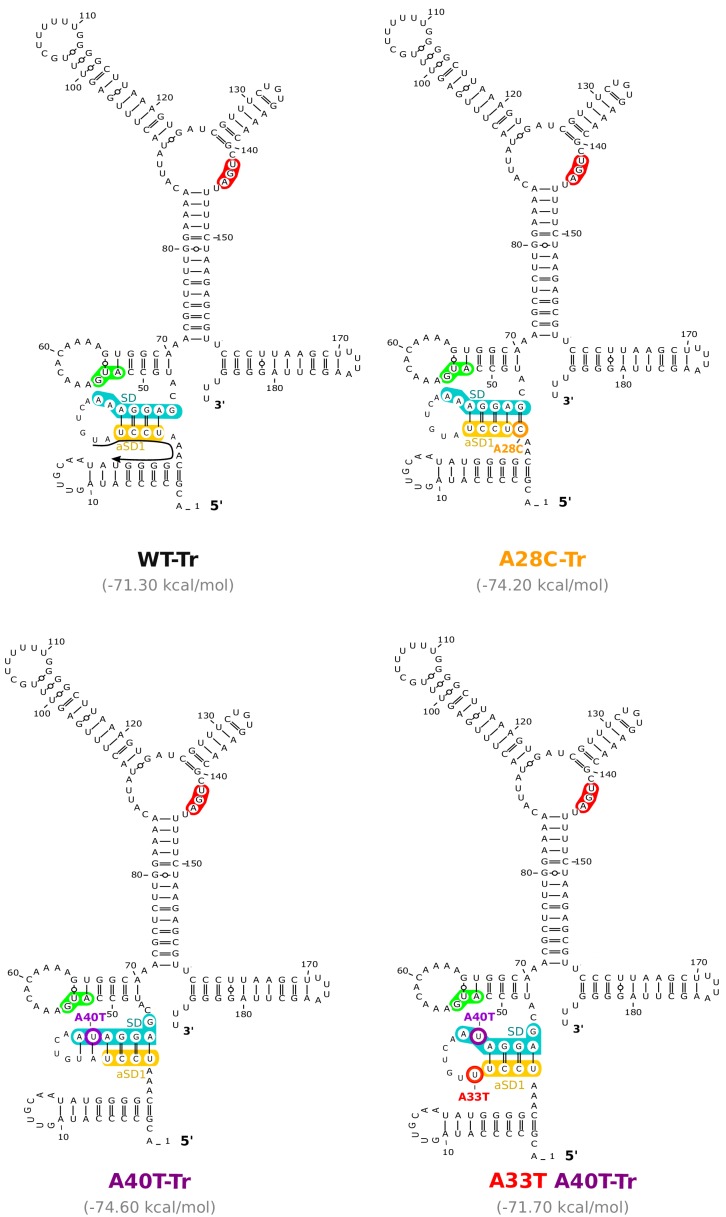
Location of the mutations working through the anti-SD sequence 1 (aSD1) in the aapA3-Tr mRNA.RNAfold Web Server (Gruber et al., 2008) was used to generate 2D structure prediction without additional constrains and VARNA (Darty et al., 2009) was used for drawing. Translation start and stop codons are highlighted in green and red, respectively. Shine-Dalgarno (SD) and anti-SD (aSD) sequences are shown in turquoise and yellow, respectively. The suppressor mutations A28C and A40T are highlighted in orange and purple, respectively. The A40T compensatory mutation A33T is shown in red. Predicted delta G values (kcal/mol) of the represented structures are shown under each structure. A small black arrow in the WT-Tr structure represents the binding site of the oligonucleotides used in the RNase H assay shown in Figure 5.